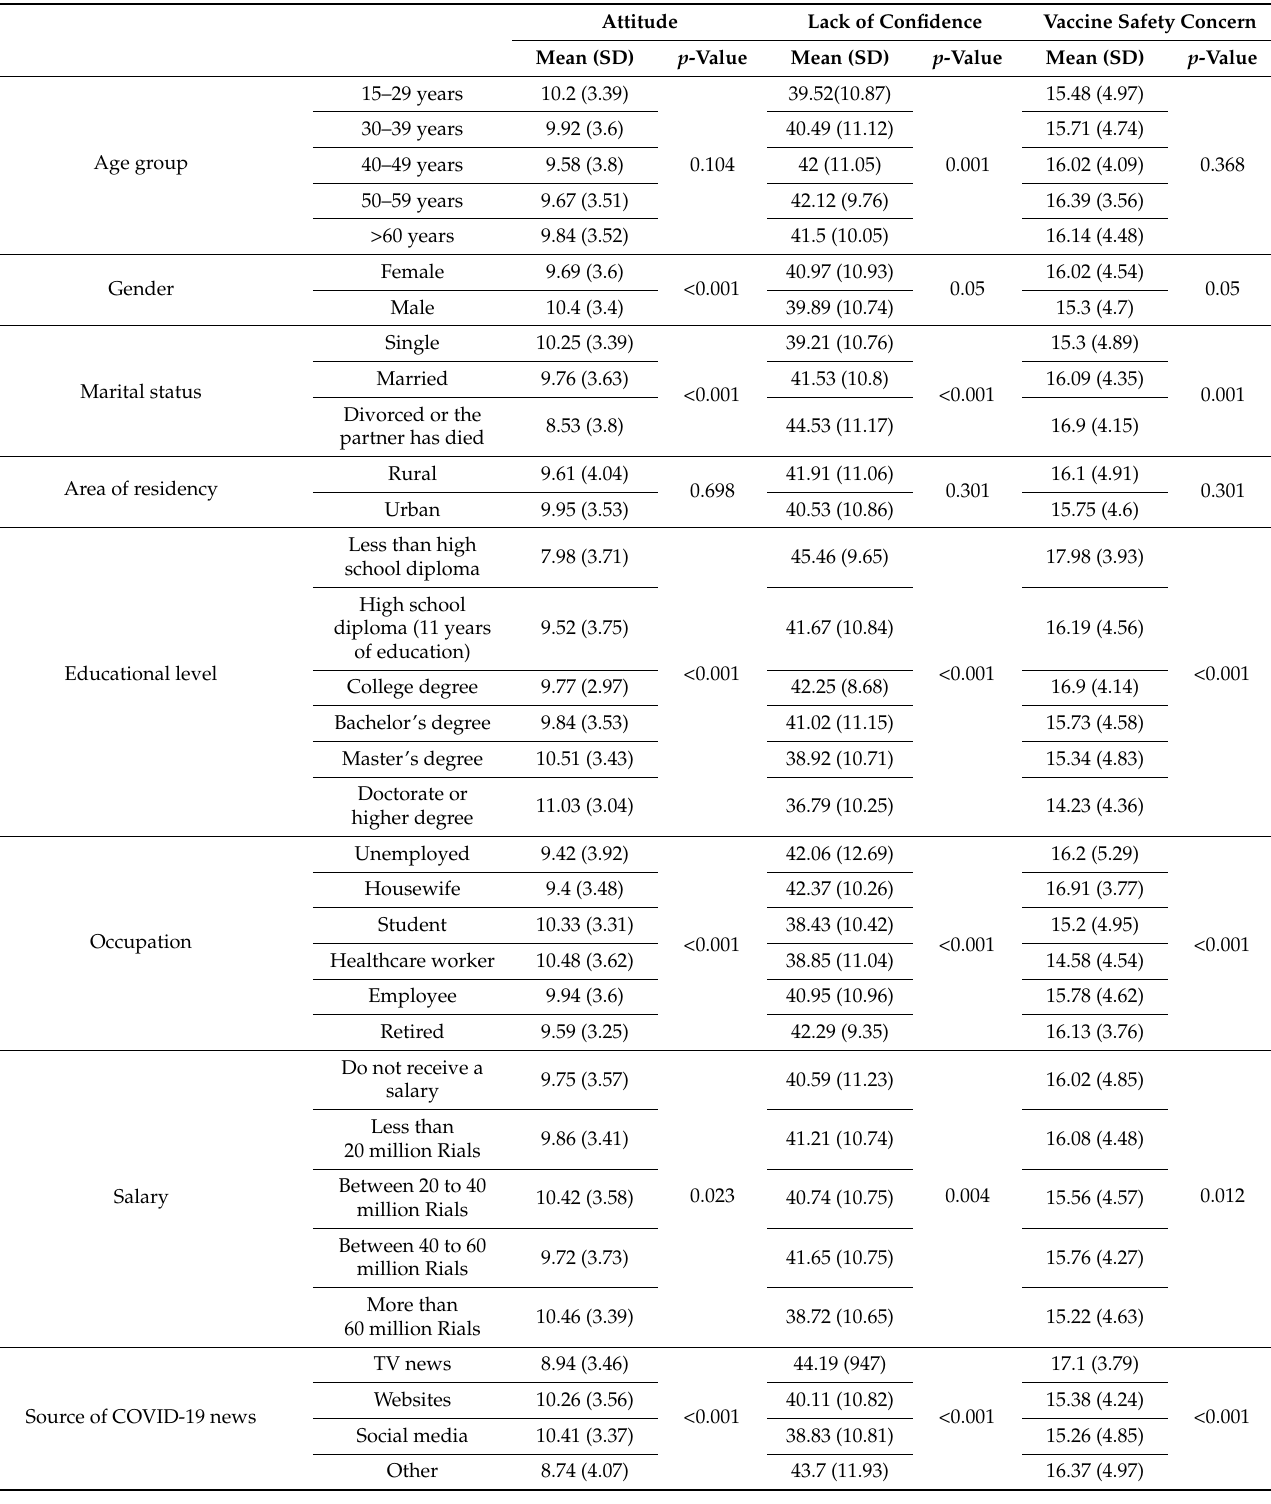
Table 2. Participants’ attitudes, concerns, and confidence regarding the COVID-19 vaccine based on their basic